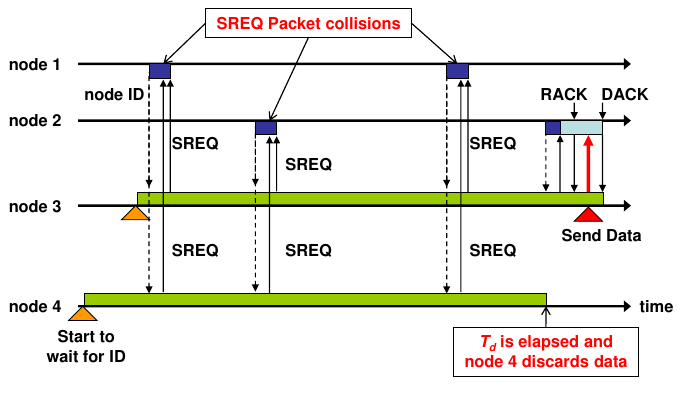
Figure 6. Recurring SREQ collisions; A major cause of excessive energy consumption in sender